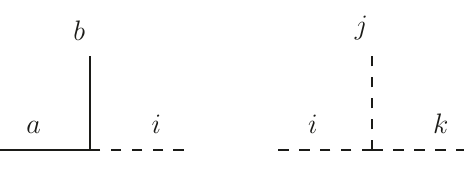
Figure 1 . The graphic presentation of T i